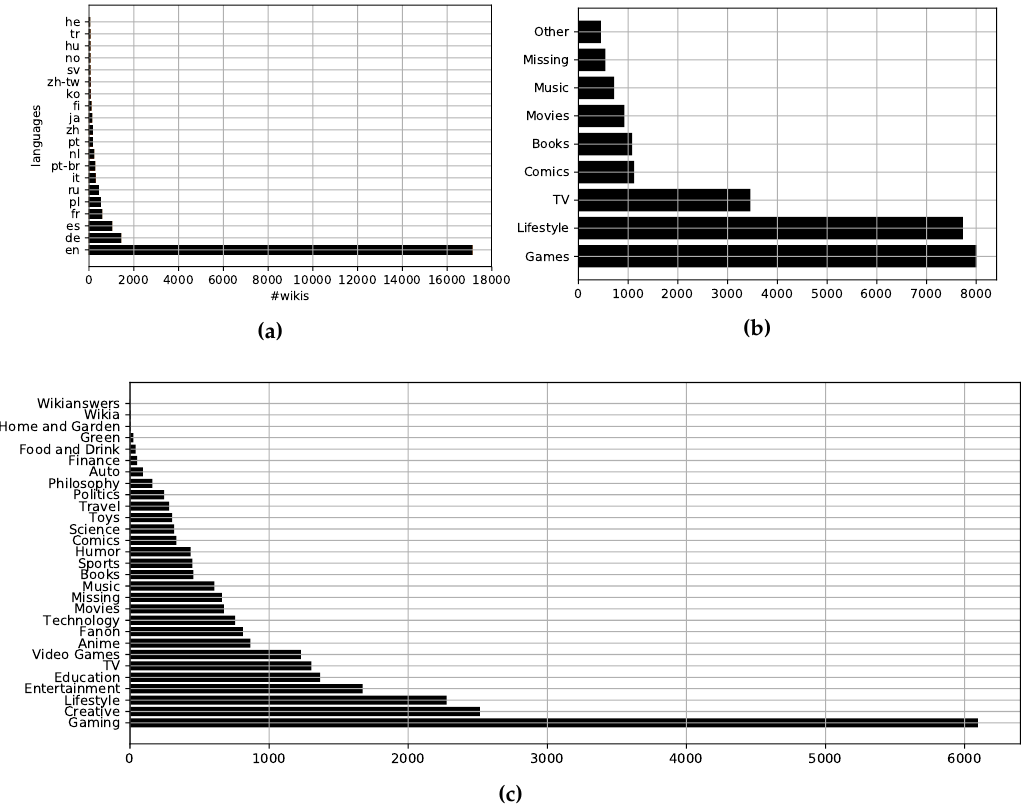
Figure 9. Breakdown of the downloaded Wikis by Language, Topic, and Hub. ( a ) Languages; ( b ) Hubs; ( c )